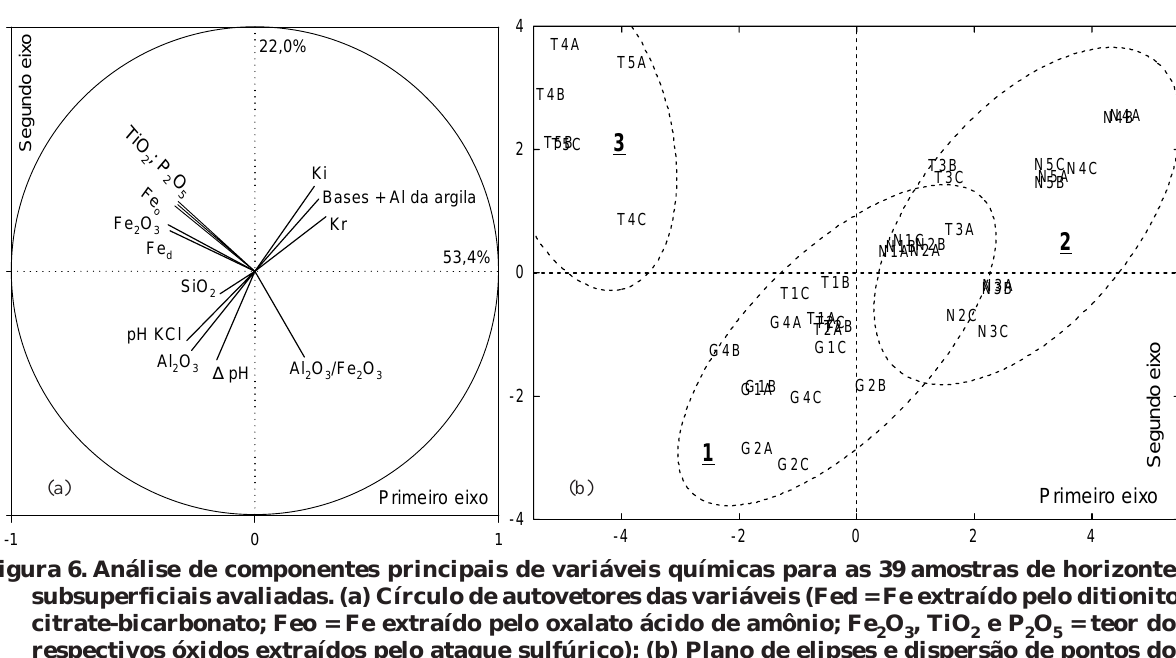
O , TiO e P O = teor dos 2 3 2 2 5